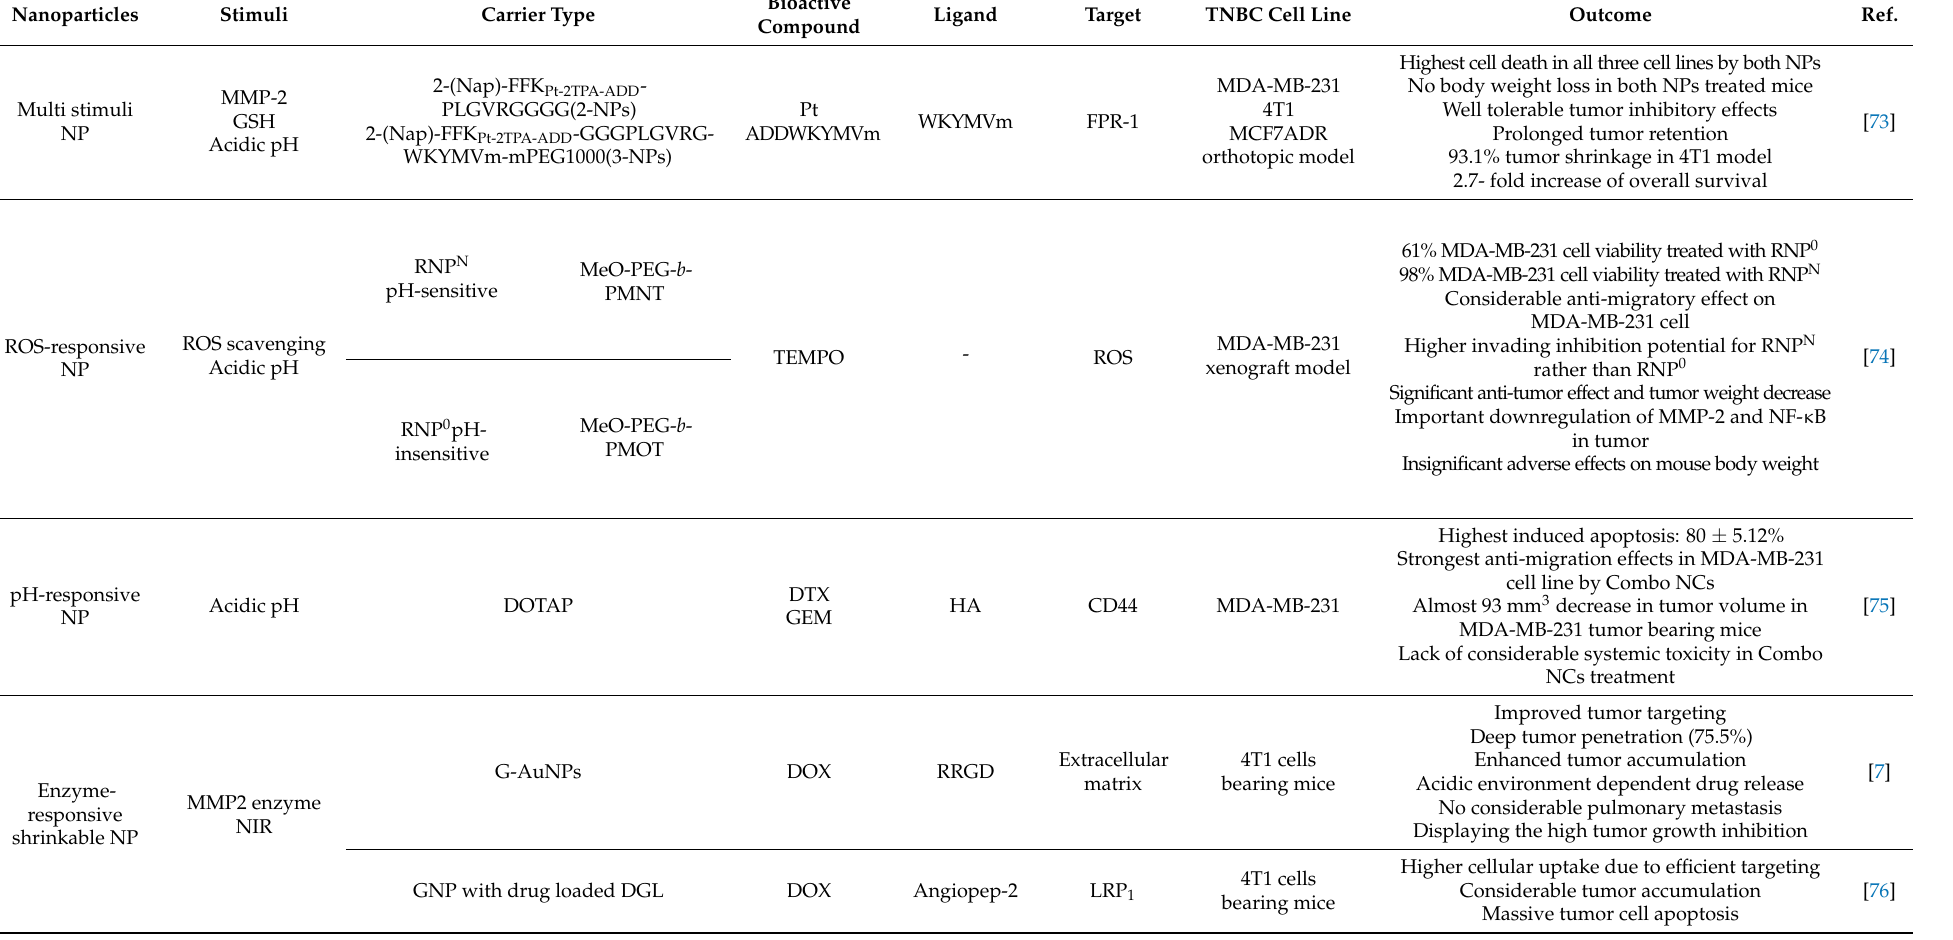
Table 1. Overview of the TME-responsive smart NPs for TNBC